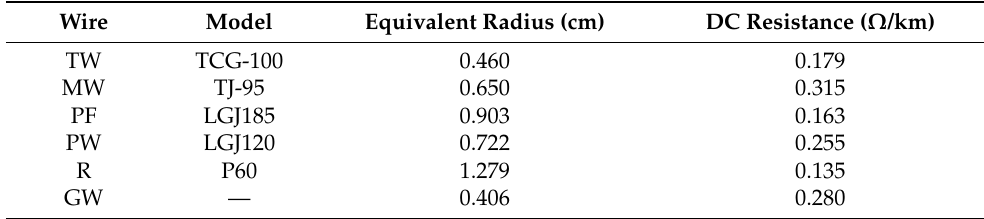
Table 1. Simulation model related parameters.